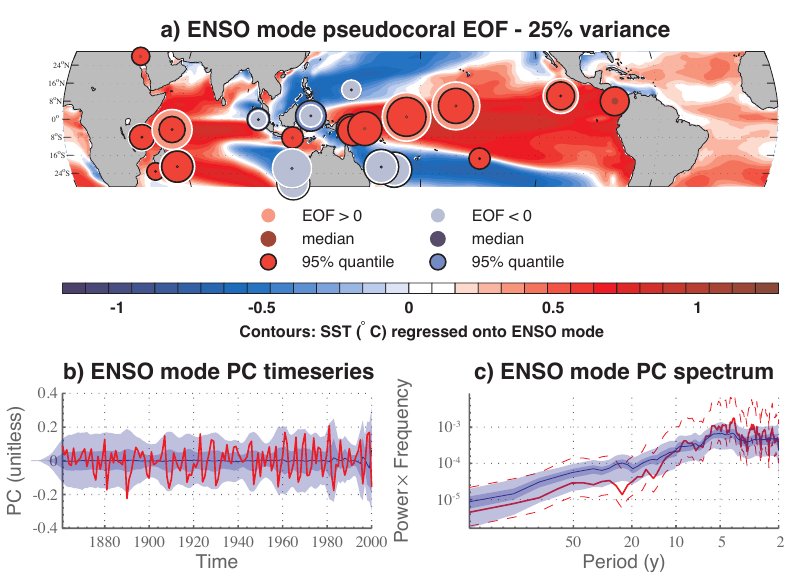
Fig. 5. Spatiotemporal uncertainty quantification on a pseudocoral network. (a) EOF loadings (circles) corresponding to the ENSO mode of an ensemble of age-perturbed pseudocoral records with miscounting rate θ = 0 . 05. EOF loadings for error-free data are shown in light colors circled in white, while the median and 95% quantile are shown by dark disks and black-circled disks, respectively. Contours depict the SST field associated with the mode’s principal component (PC) (b) , whose power spectrum is shown in (c) . Results for the time-uncertain ensemble are shown in blue: median (solid line), 95% confidence interval (light-filled area) and interquartile range [25–75%] (dark-filled area). Results for the original (error-free) data set are depicted by solid red lines. Dashed red lines denote χ 2 error estimates for the MTM spectrum of the error-free data